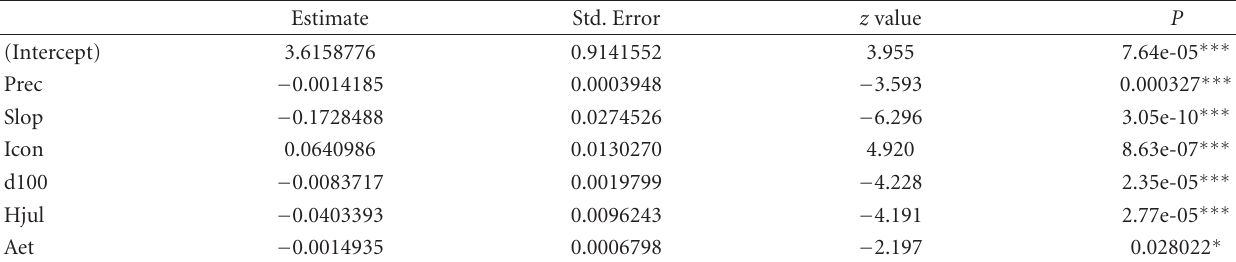
Table 8: B. calamita and not B. bufo